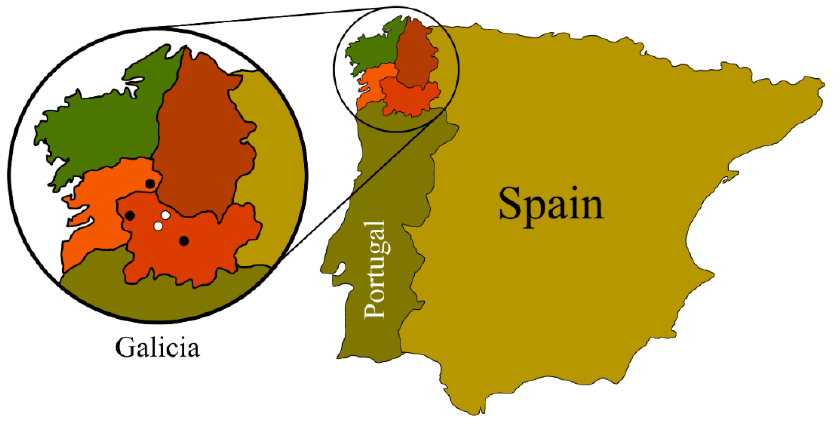
Figure 1. Sketch of the Iberian Peninsula with the approximate location of the stations used in this research. Derivative work from ME2000raster 2020 CC-BY 4.0 ign.es [39].